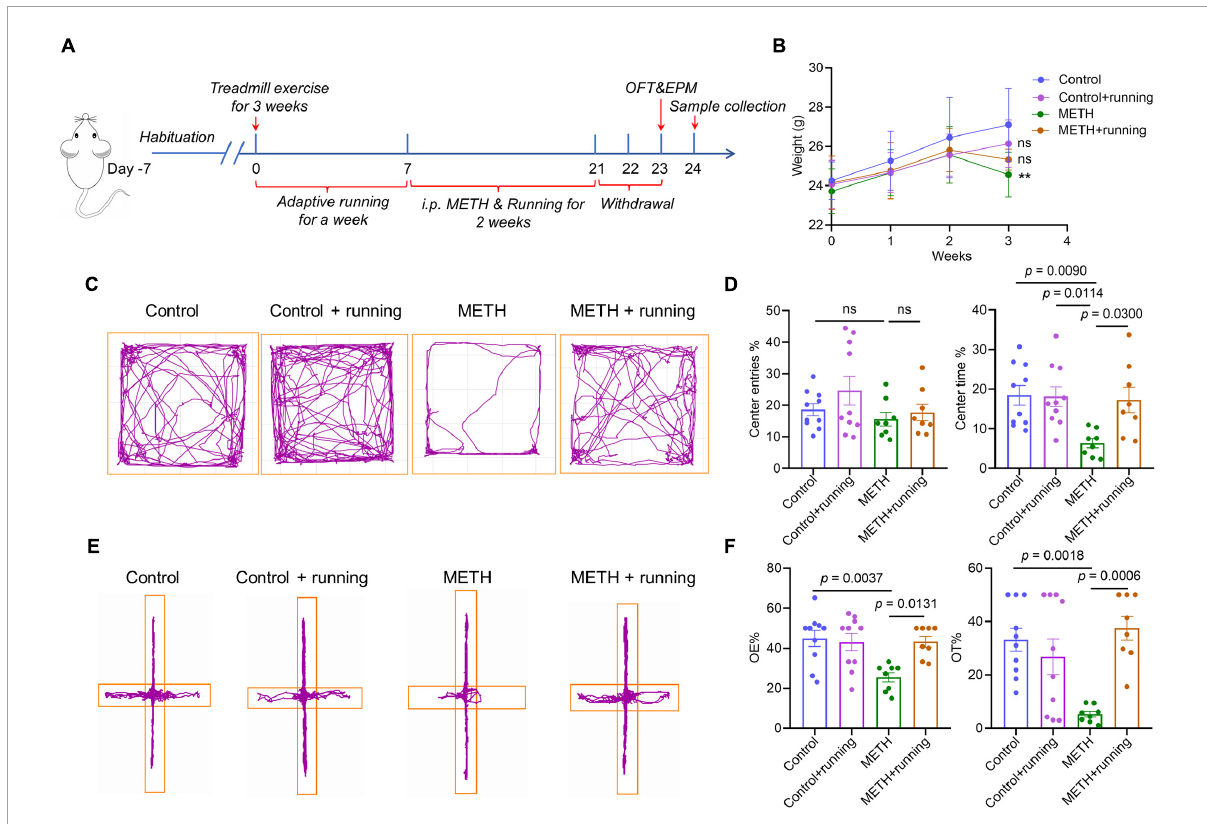
FIGURE3 Treadmill exercise improved the acute METH withdrawal–induced anxiety-like symptoms in mice. (A) The timeline of the mouse model of treadmill exercise ameliorating anxiety-like symptoms in the METH acute withdrawal period. (B) The changes in body weight in four groups of mice within 3 weeks, and the data were analyzed by one-way analysis of variance (ANOVA) for multiple comparisons followed by a post hoc Tukey test. (C) The behavioral trajectories of mice in the four groups in the open field test. (E) The behavioral trajectories of mice in the four groups in the elevated plus maze experiment. (D) The behavioral experiment results of the OFT test in the control group ( n = 10), control + running group ( n = 10), METH group ( n = 8), and METH + running group ( n = 8). (F) The behavioral experiment results of the EPM test in the control group ( n = 10), control + running group ( n = 10), METH group ( n = 8), and METH + running group ( n = 8). The data are expressed as the mean ± SEM, and p < 0.05 was considered a significant